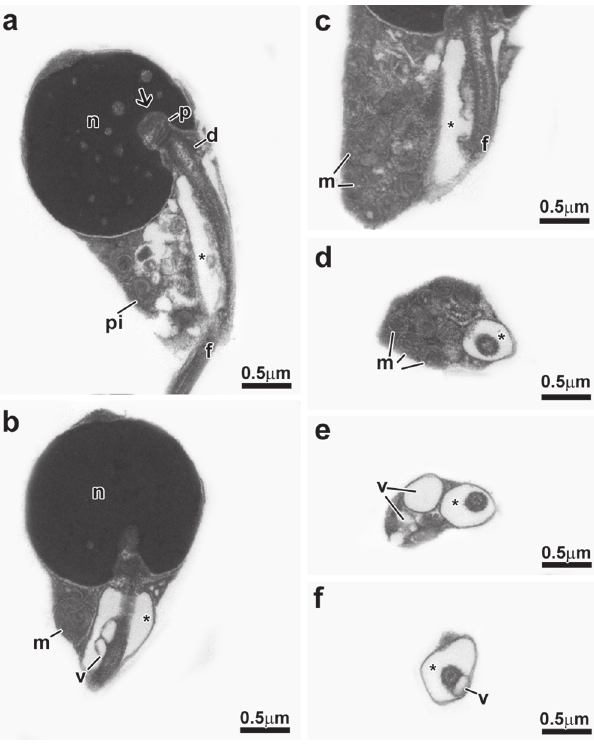
Fig. 3. Spermatozoon of Alestopetersius compressus . a, b, c: longitudinal sections. d, e, f: transverse sections from top to posterior region. The nucleus (n) is spherical and lies eccentric to the flagellum (f). The centriolar complex (p, d) and nuclear fossa (arrow) is eccentric. The proximal centriole (p) is oblique relative to the distal centriole (d). The cytoplasmic canal is present (asterisk). The midpiece (pi) is strongly asymmetrical, and contains the spherical mitochondria (m) and vesicles (v). The flagellar membrane has some vesicles and the